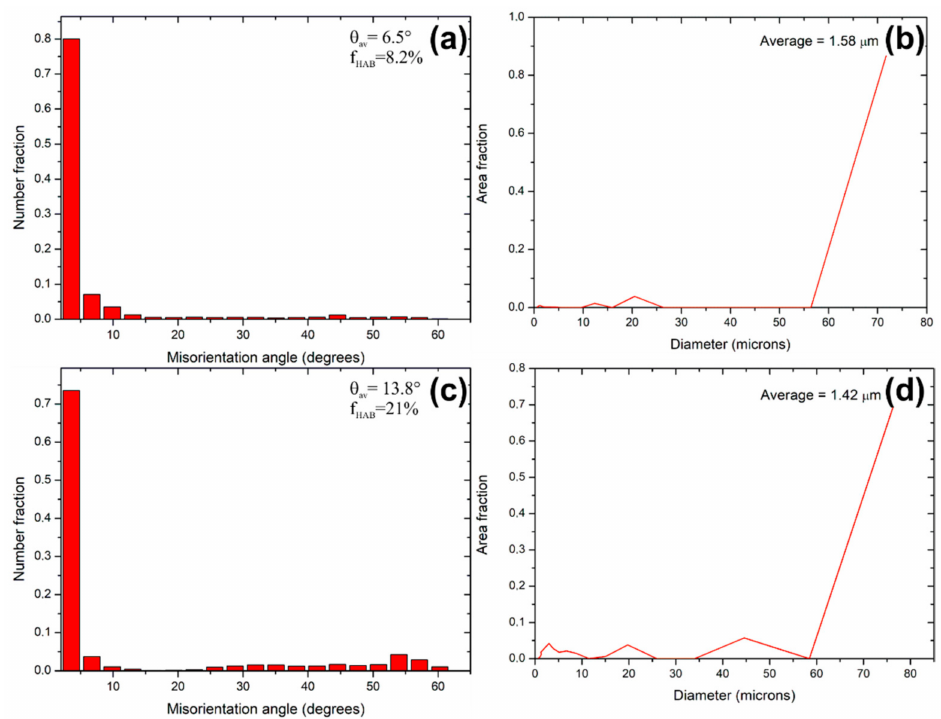
Figure 6. Grain size distribution and misorientation maps of AlMg3 alloy ( a , b ) upsetting without ultrasonic vibrations (USV), ( c , d ) upsetting with